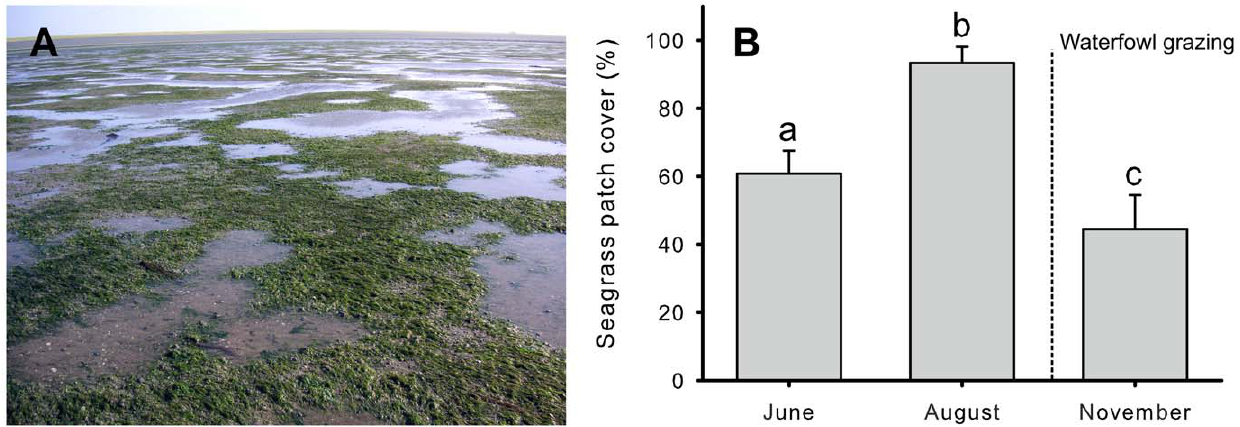
Figure 1. Low-tide exposed hummocks with seagrass alternate with waterlogged, bare hollows in June (A). Seagrass patch cover changed significantly over time (ANOVA: F 2,17 =66.6, p , 0.001) from about 61% in June, to over 93% in August, followed by a sudden decrease again to 44% in November due to waterfowl grazing in September and October (B). Error bars indicate SD (number of replicates=6).